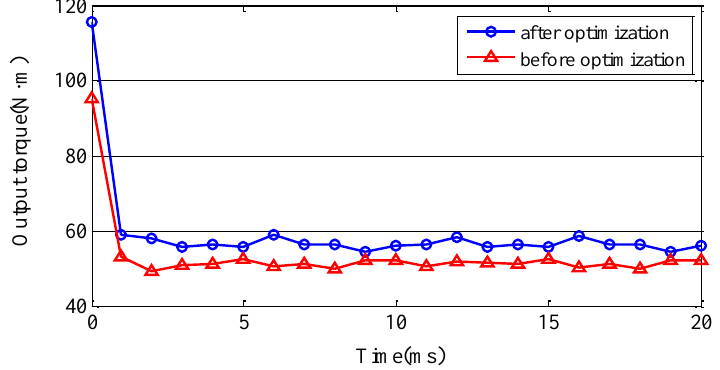
Figure 11. Output torque comparison curves before and after optimization.